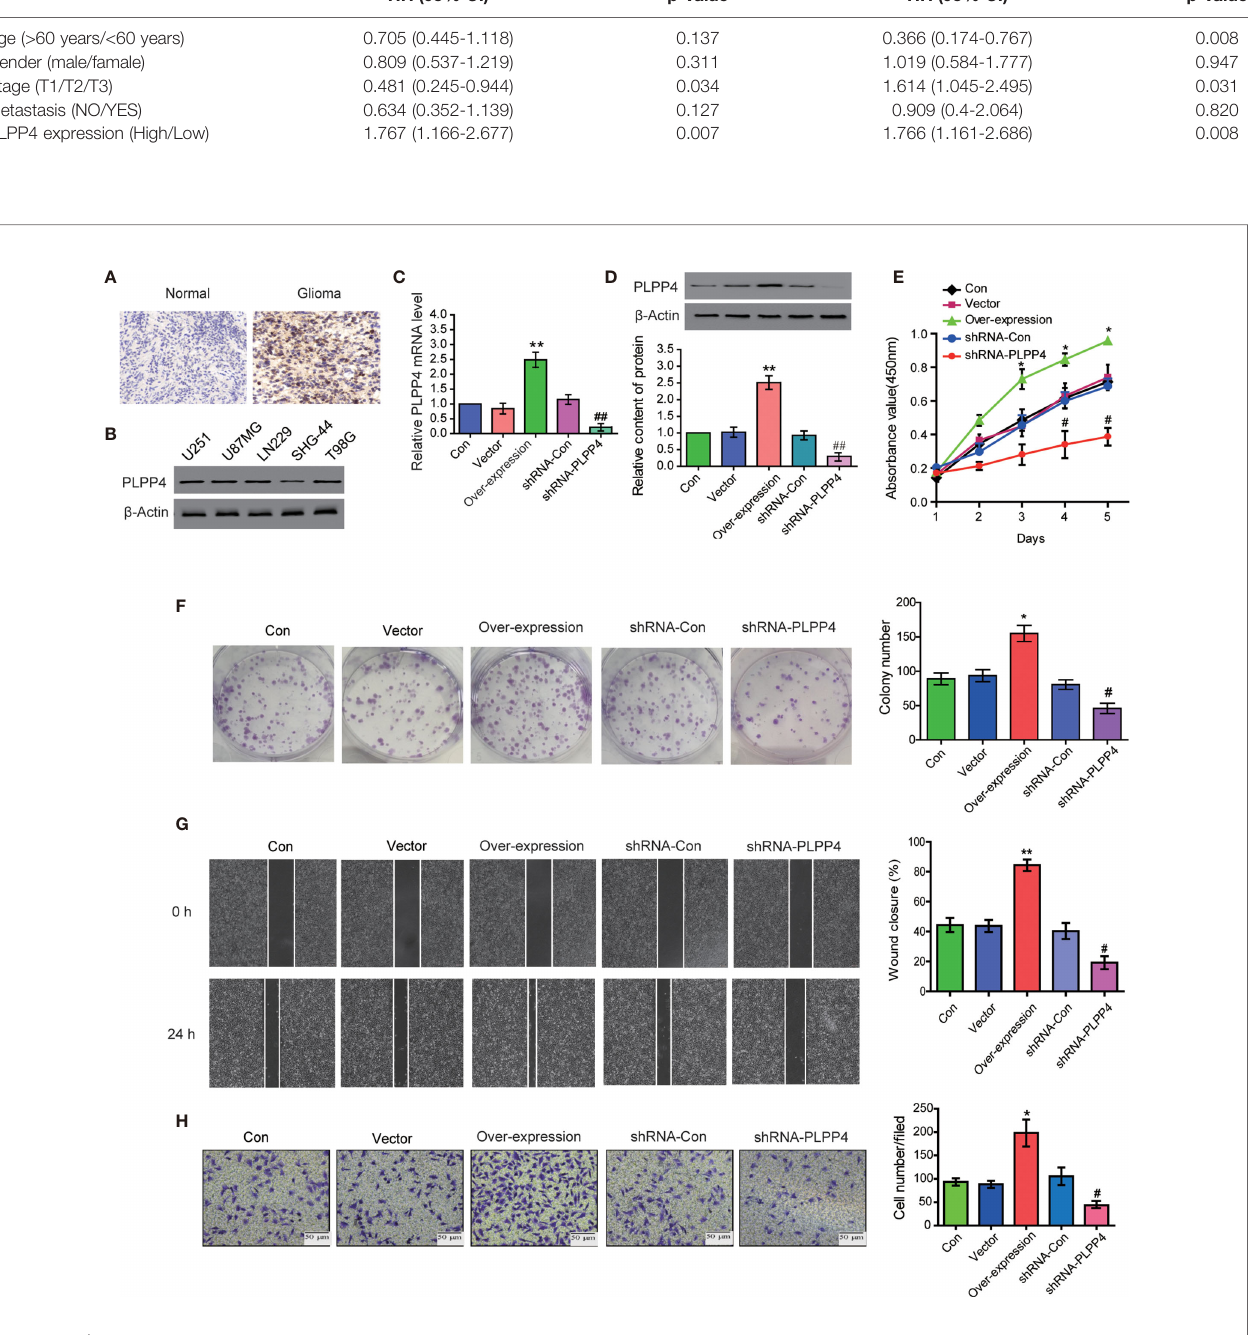
FIGURE 8 | PLPP4 promoted the proliferation, migration, and invasion of glioma LN229 cells. (A) Representative image of immunohistochemical analysis of paraf fi n- embedded primary glioma tissue specimens (enlarged X400). PLPP4 staining was stronger in glioma tissues than in normal tissues with a scale of 20 m m. (B) PLPP4 expression in different glioma cell lines. (C) Real-time PCR assay was used to detect the expression of PLPP4 (vector, over-expression, shRNA-con, shRNA-PLPP4) in each group of LN229 cells. (D) Western blot analysis was performed to detect PLPP4 expression (vector, over-expression, shRNA-con, shRNA-PLPP4) in each group of LN229 cells. (E) CCK-8 assay (at 1, 2, 3, 4, 5 days) in LN229cells. PLPP4-interference inhibited the proliferation of LN229 cells. (F) Silencing PLPP4 reduced the mean colony number according to the colony formation assay. (G) The migration of LN229 cells in each group was detected by the scratch method. (H) In invasion assay, representative images of LN229 cells (vector, over-expression, shRNA-con, shRNA-PLPP4) (×100). Each bar represents the mean values ± SEM of three independent experiments. Compared to vector, * P < 0.05, ** P < 0.01; compared to shRNA-Con, # P < 0.05, ## P <